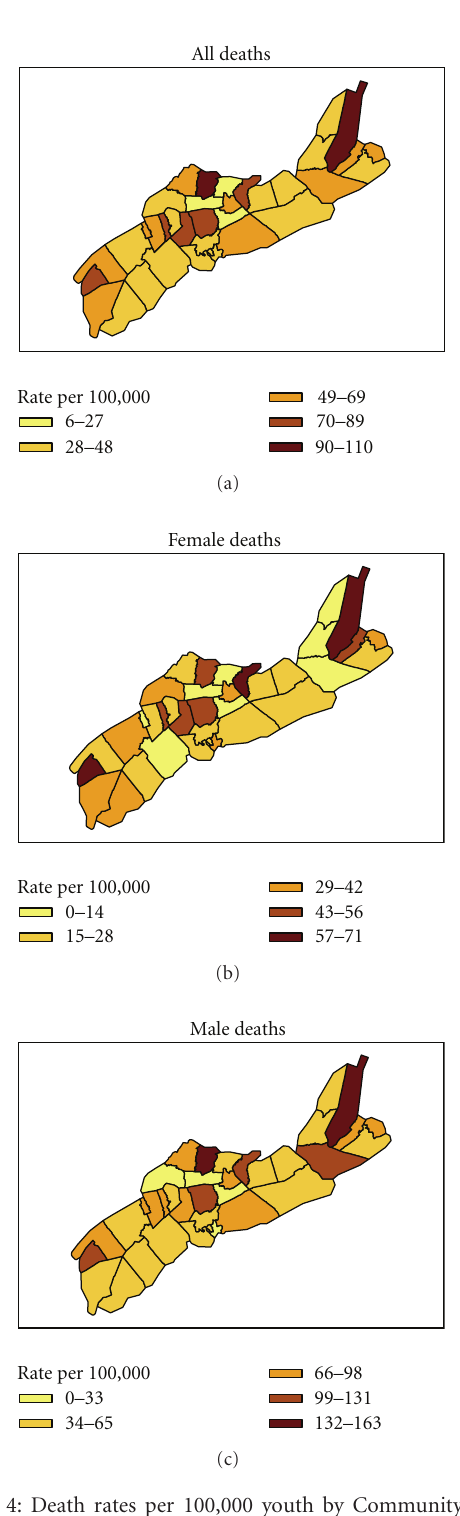
Figure 4: Death rates per 100,000 youth by Community Health Board.